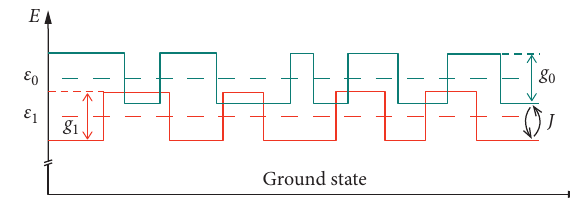
Figure 3: Uncorrelated random fluctuations applied to donor and and ε . Each molecule is affected acceptor’s excited state energies, ε 0 1 by one fluctuator, which generates a telegraph-type classical noise. The fluctuators switch randomly between the positive and negative values at a given fixed rate, so that the periods of time when the molecule energy is constant, ε m + ( g m /2 ) or ε m − ( g m /2 ) , are random. J is the coupling strength between the molecules that can be seen as the rate of hoppings between these fluctuating energy levels.